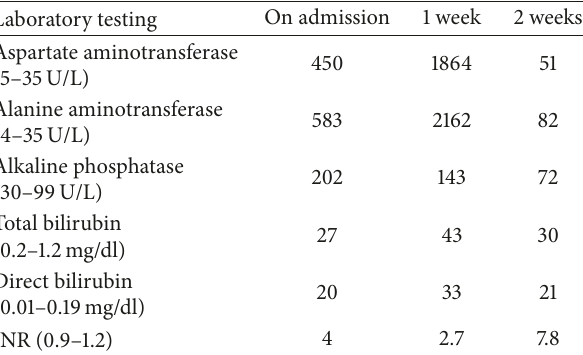
Table 3: 18-ingredient list contained in the Yogi Detox Tea and the articles published in PubMed highlighting their